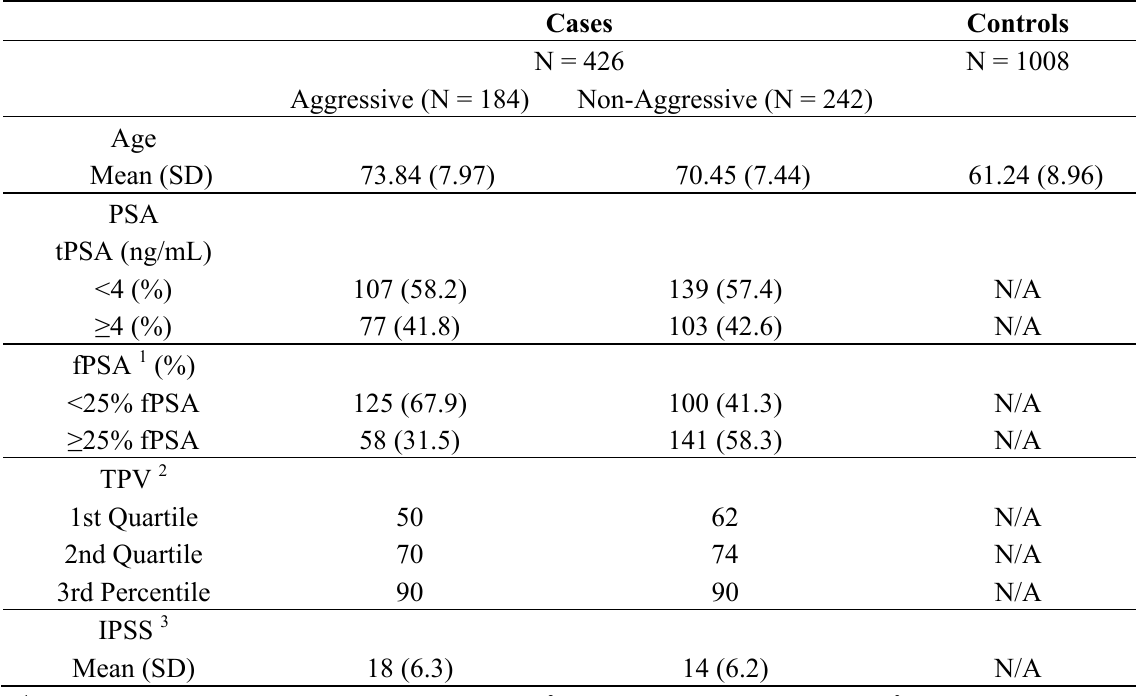
Table 1. Clinical and demographic characteristics of all